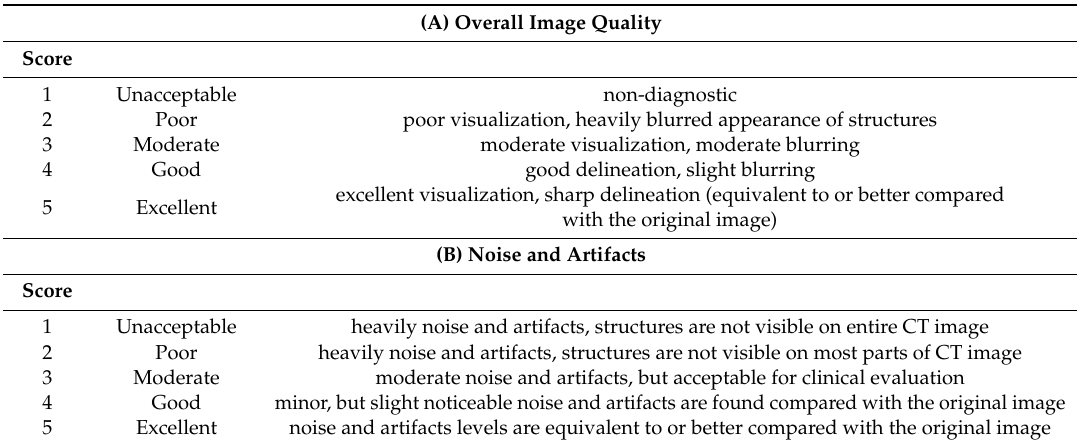
Table 1. Score criteria for entire CT image quality.